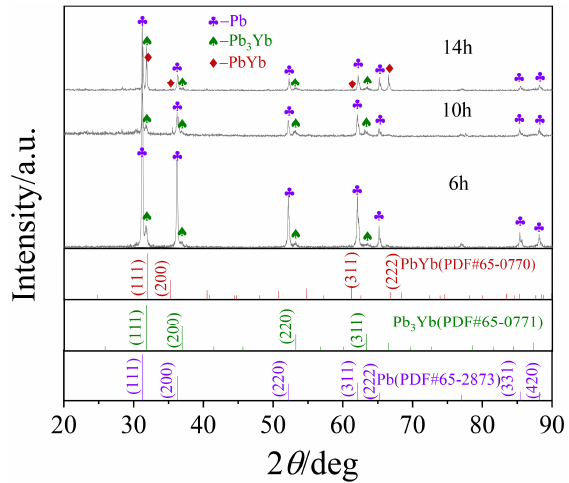
Figure 11. XRD patterns of the cathode products on a liquid Pb electrode in molten LiCl-KCl-YbCl 3 salts through PE at − 1.86 V for 14 h at 773 K.